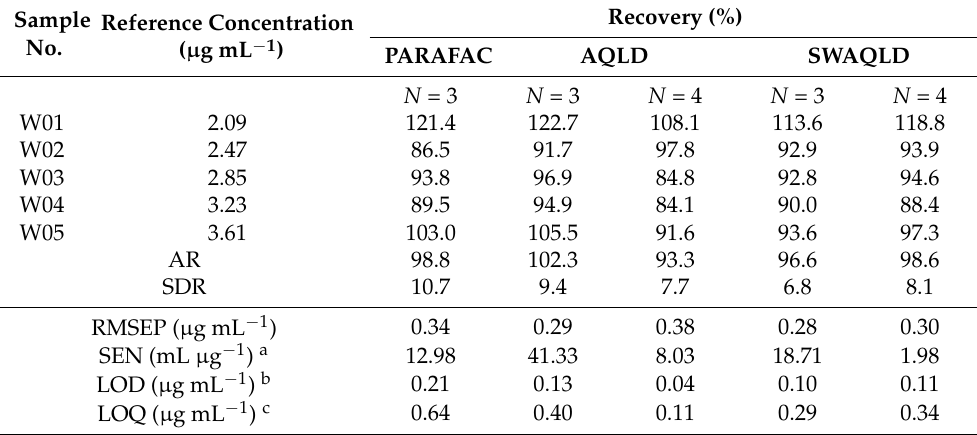
Table 2. Statistical figures of merit concerning the fluorene quantification in wastewater samples by using third-order calibration methods (PARAFAC, AQLD, and SWAQLD) with different rank values. Sample Reference No.